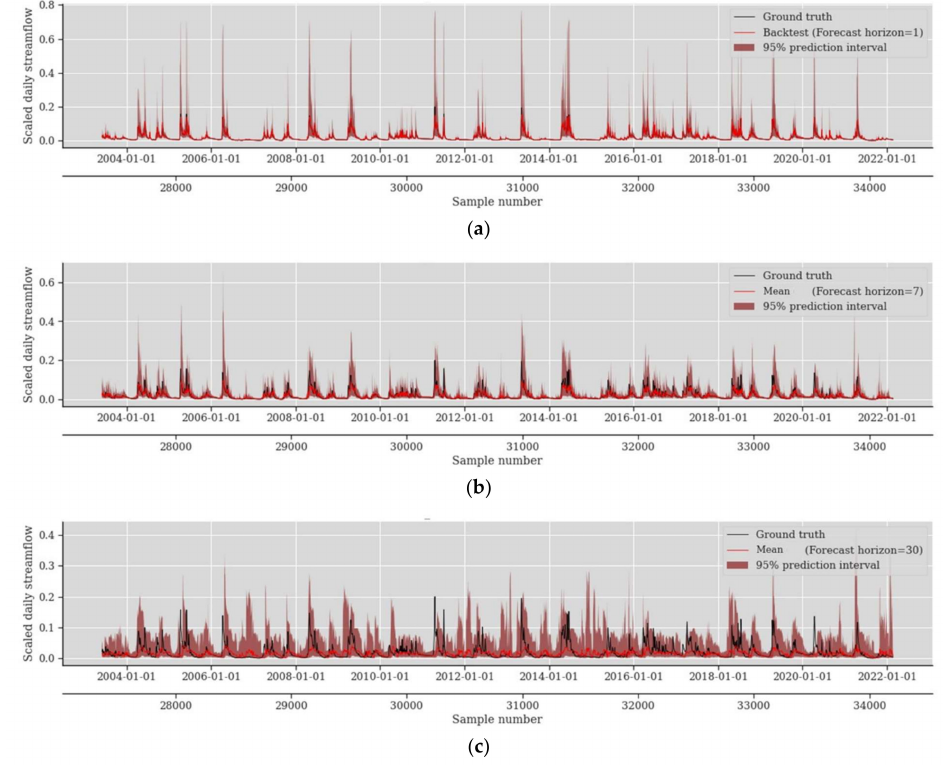
Figure 10. Probabilistic streamflow forecasting results obtained by LSTM-MC for case study II ( a ) forecast horizon 1, ( b ) forecast horizon 7, and ( c ) forecast horizon